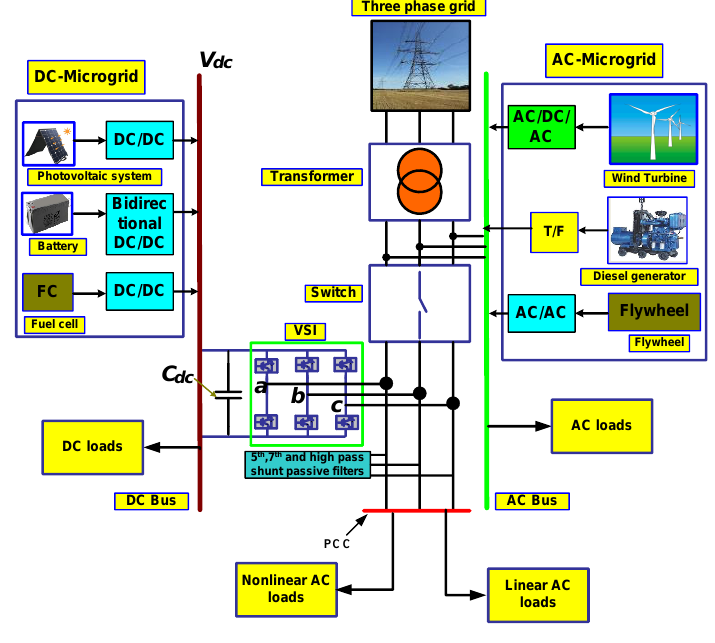
Figure 1. Proposed system.